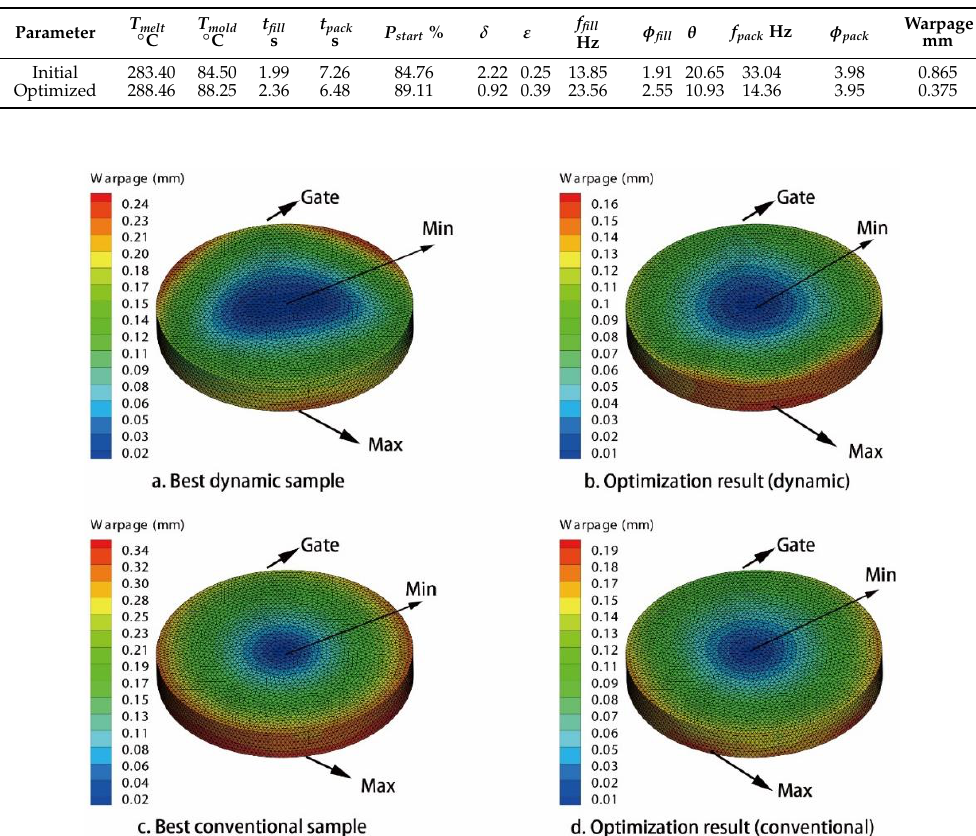
Table 15. Dynamic parameters and warpage results of the PC car light cover.